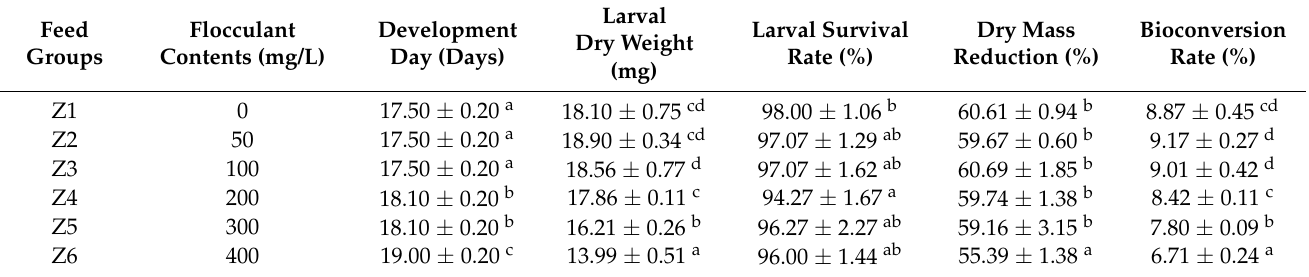
Table 1. Development days, larval survival rate, dry mass reduction, and feed conversion ratio (dry mass) and the bioconversion (dry mass) of different treatment